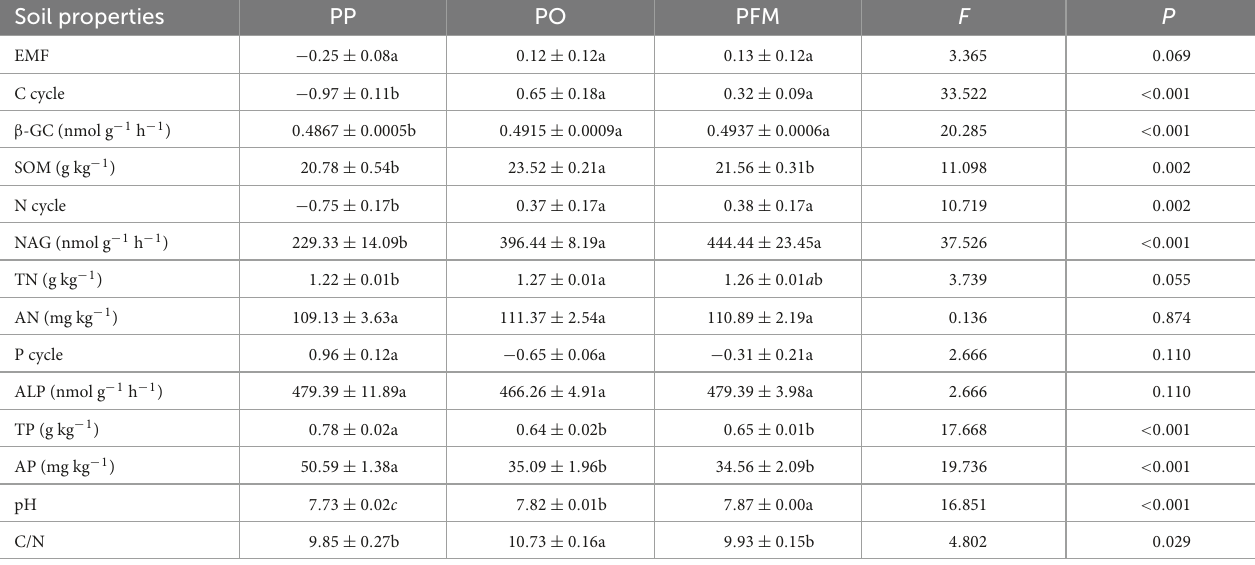
TABLE 1 The soil chemical properties, enzyme activities, and multifunctionality under different crop rotations. Soil properties